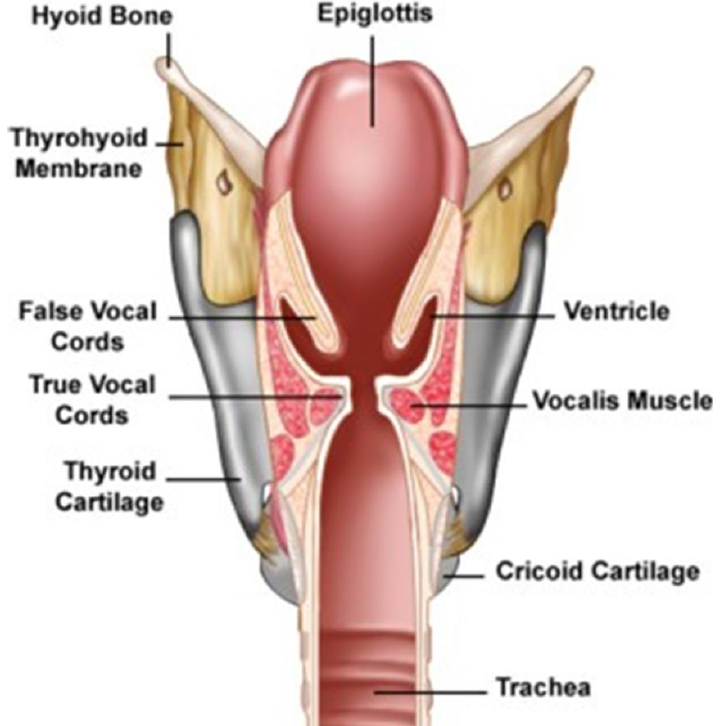
Fig. 1: Cavity of the Larynx showing true and false vocal